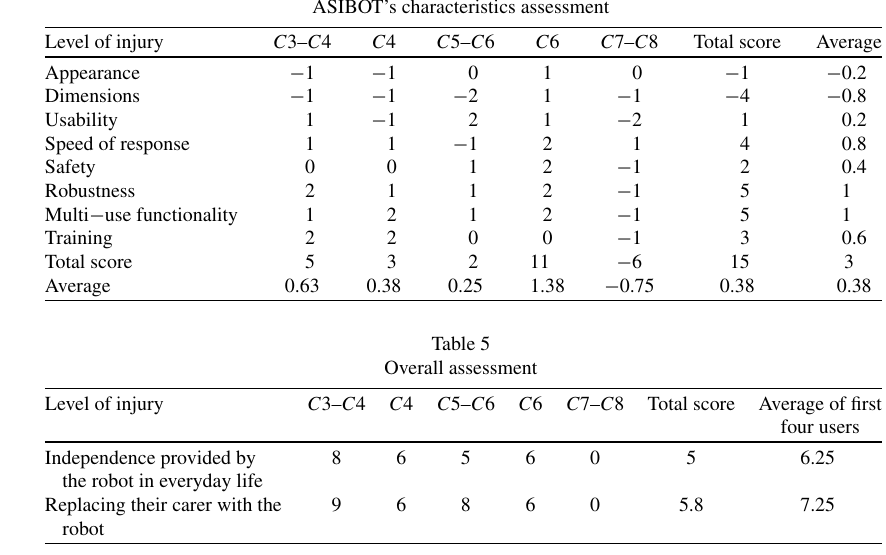
Table 4 ASIBOT’s characteristics assessment